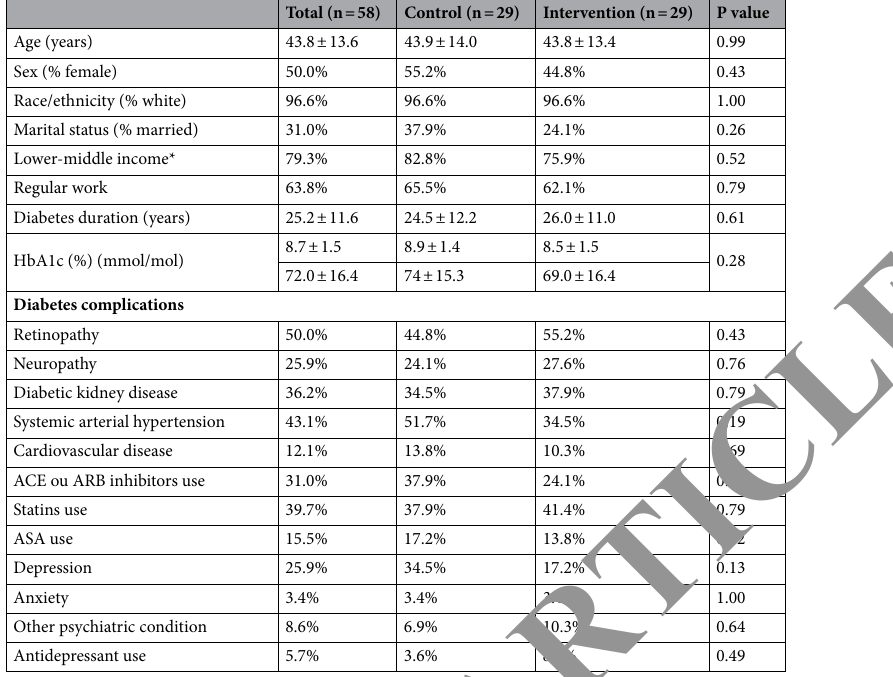
Table 1. Baseline characteristics of study participants. Data are mean ± standard deviation or %. HbA1c hemoglobin A1c, ACE angiotensin-converting enzyme, ARB angiotensin II receptor blocker, ASA acetylsacylic acid. α ≤ 0.05 indicates significant difference. *Lower-middle income: family that receives less than 2564 reais per month, as defined by the Strategic Affairs Secretariat (SAE) of Brazil, equivalent to 495.8 dollars or 430